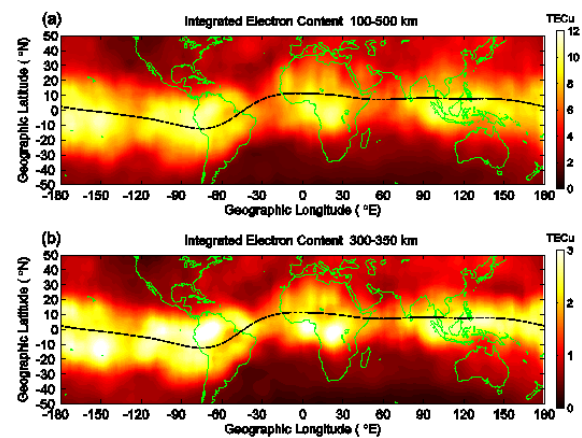
Fig. 39. 30-day mean vertically integrated electron content (TECu) for 20:00 to 22:00 local time over the layers 100–500km (top) and 300–350km (bottom) as observed by COSMIC during Septem- ber 2006. TECu in 10 12 electronscm − 2 . Monthly averaged values obtained by binning measurements from 30 geomagnetically qui- escent days (15days prior and 15days after 21 September) in two hour bins and taking median value of the soundings located in the same 5 degree by 5 degree grid in both longitude and latitude (Lin et al., 2007c).